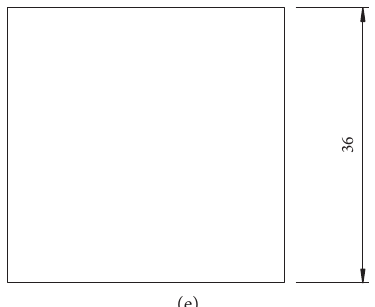
Figure 11: Layout of measuring points for large opening model. (a) Layout of measuring points on facade. (b) Layout of measuring points on standard layer. (c) Layout of measuring points on the opening layer. (d) Dimensions of large openings. (e) Cross dimensions. Table 1: Wind speed ratios of a 1 –a 11 monitoring points of the L-3 model under the wind direction of 0 Monitoring point Upper opening Lower opening The bold values represent the maximum wind speed ratios for upper opening and lower opening, respectively. Table 2: Wind speed ratios of a 1 –a 11 monitoring points of the S-1 model under the wind direction of 0 Monitoring point a 1 Upper opening Lower opening The bold values represent the maximum wind speed ratios for upper opening and lower opening, respectively. Table 3: Variation of wind speed of monitoring point b 1 on the L-3 model with wind direction (m/s). Wind direction 0 ° V X